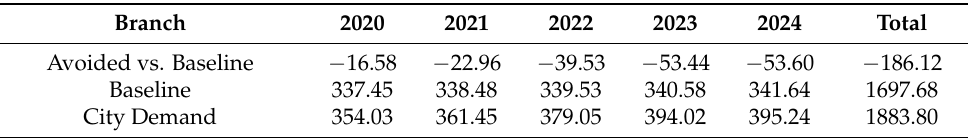
Units: thousand metric tonnes CO 2